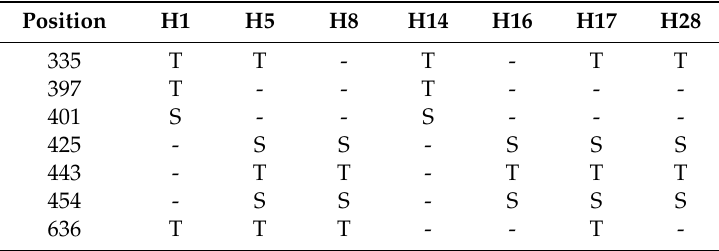
Table 1. Phosphorylation sites of NADPH-cytochrome P450 reductase-1 encoding by different haplotypes of O. sinensis .